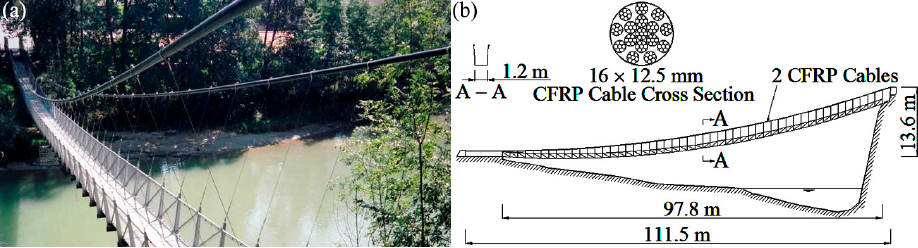
Figure 11. Neigles CFRP footbridge, ( a ) photo (photo credit: Tokyo Rope) and ( b ) sketch.